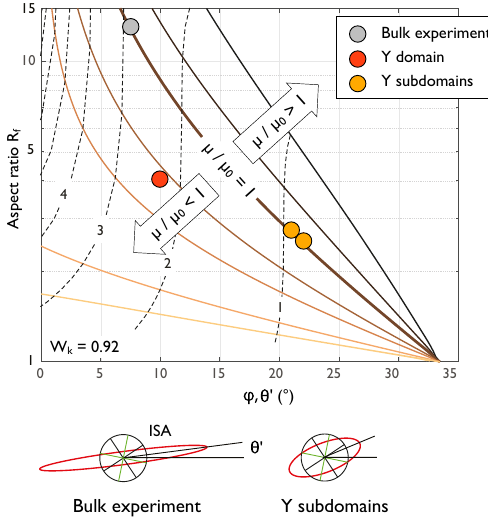
Figure 12. Relation of quartz domains and bulk sample strain. R f − φ type plot calculated for general shear. Contours (solid lines) are for viscosity ratios κ = µ/µ 0 of 0.01, 0.5, 1, 2, 3, 6, and 9 cal- culated for the linear viscous case. Dashed lines represent constant shear strain. For w935, the ratio of principal stretches R f = 12 . 9; the trend of the major axis of the strain ellipse (cid:50) (cid:48) = 7 . 5 ◦ ; the kinematic vorticity number W k = 0 . 92. Aspect ratios of the Y subdomains are 2.5 and 2.7; the corresponding trend of the long axes ( φ ) is 22 and 21 ◦ . Strain ellipses for bulk sample and Y subdomains are shown